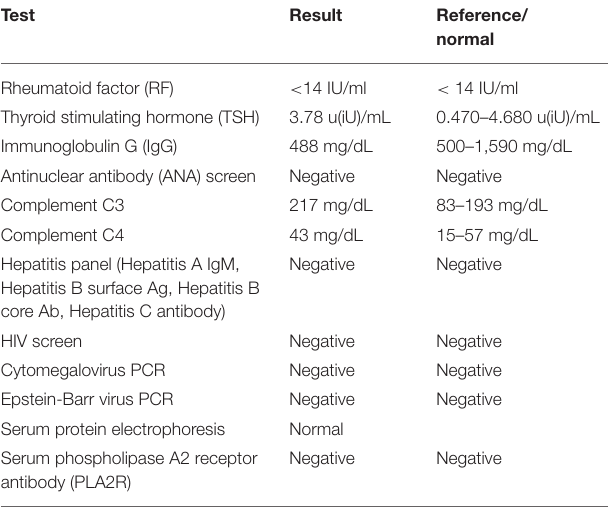
TABLE 1 | Viral and immunological